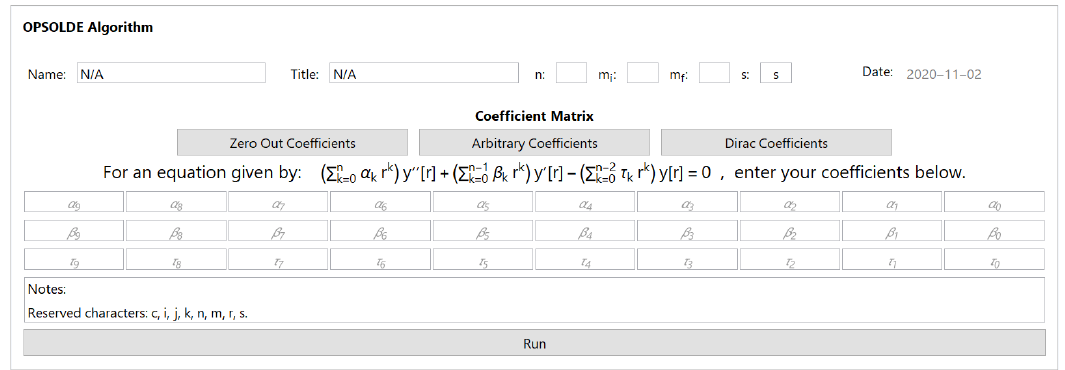
Figure 1. The OPSOLDE Algorithm GUI. Upon inputting an integer value of n ∈ [ 2,9 ] , the coefficient field will resize appropriately and permit the user to choose the values for each coefficient. A working example is provided: by selecting “Dirac Coefficients” and the program will generate the results discussed in Section 5.2 of this